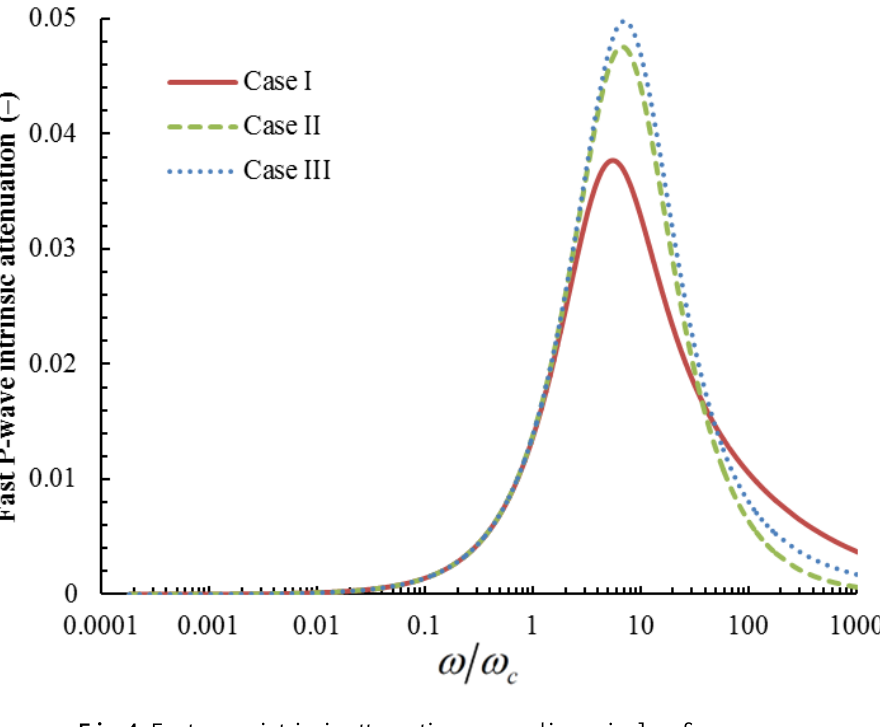
Fig. 4. Fast wave intrinsic attenuation versus dimensionless frequency.